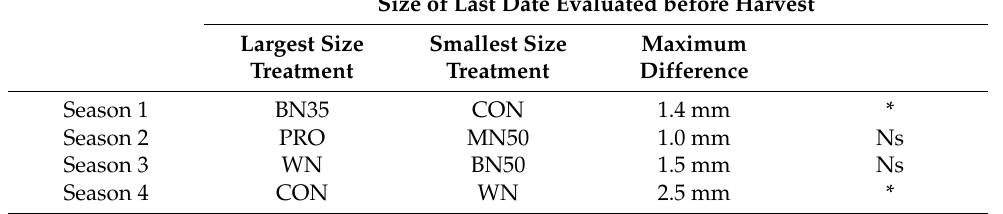
Table 1. Fruit size difference between smallest and largest size at harvest by season and